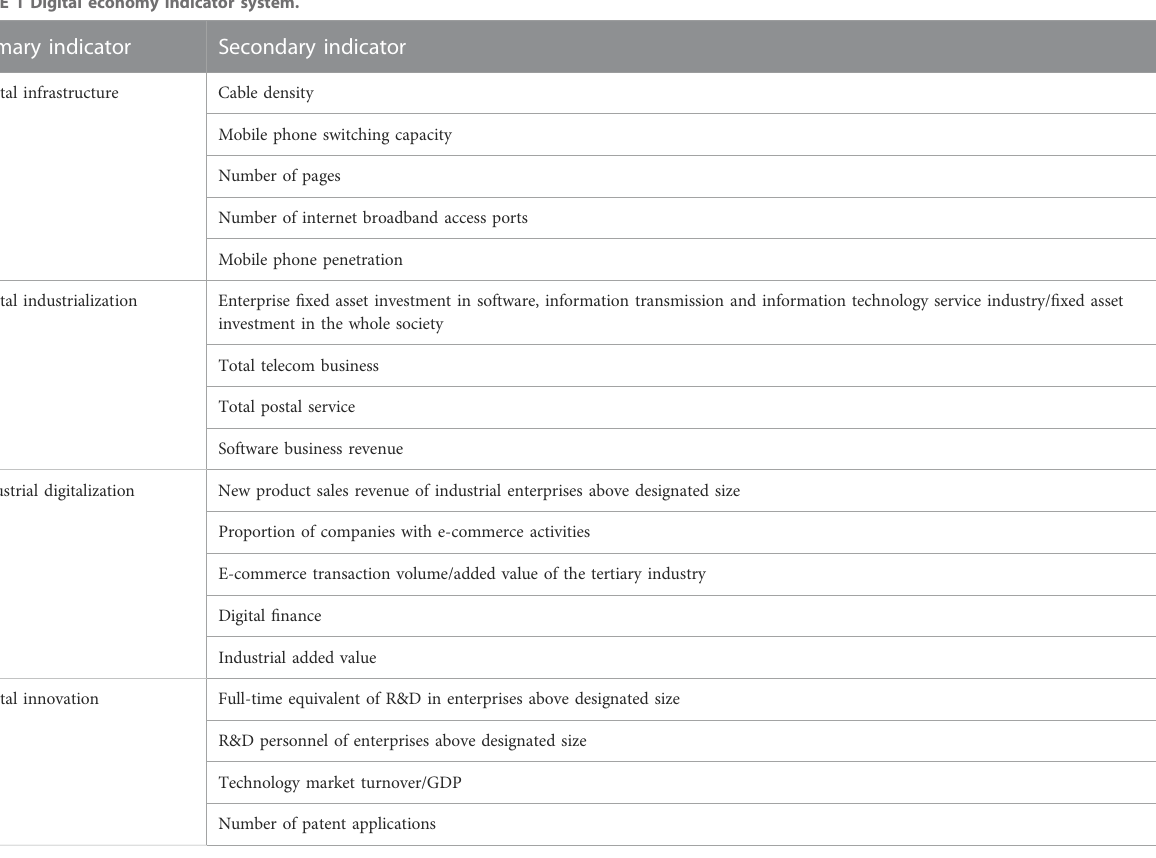
TABLE 1 Digital economy indicator